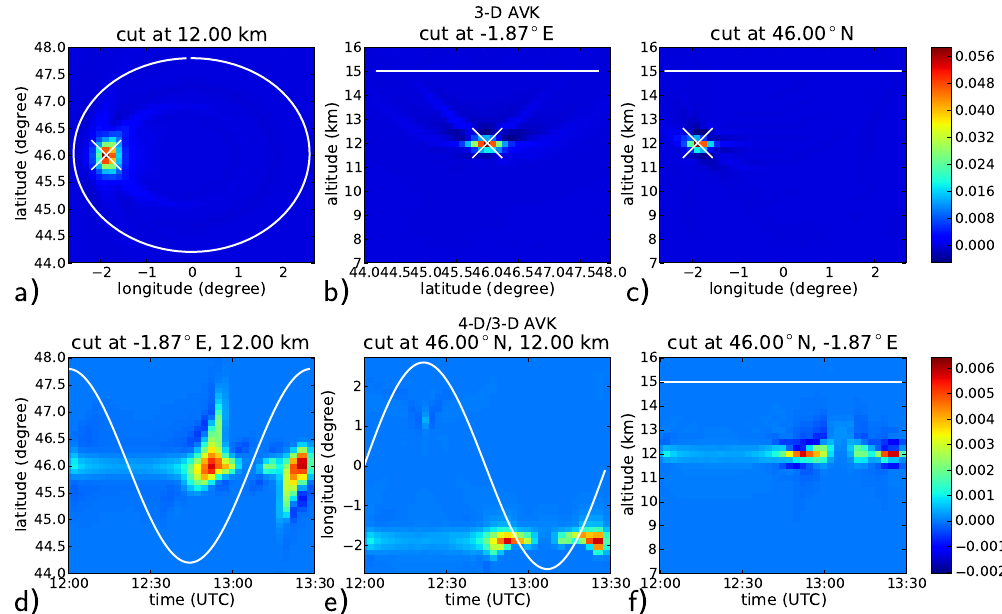
Fig. 13. A comparison between one row of the 3-D averaging kernel matrix and its 4-D/3-D equivalent for a border element. In the upper row of panels three cutting planes through a row of the 3-D averaging kernel matrix are depicted, all belonging to the element at 1.87 ◦ W, 46 ◦ N, and 12km altitude. For the same element, the lower row of panels depicts three cutting planes through the 4-D space described by the row of the 4-D/3-D averaging kernel matrix.